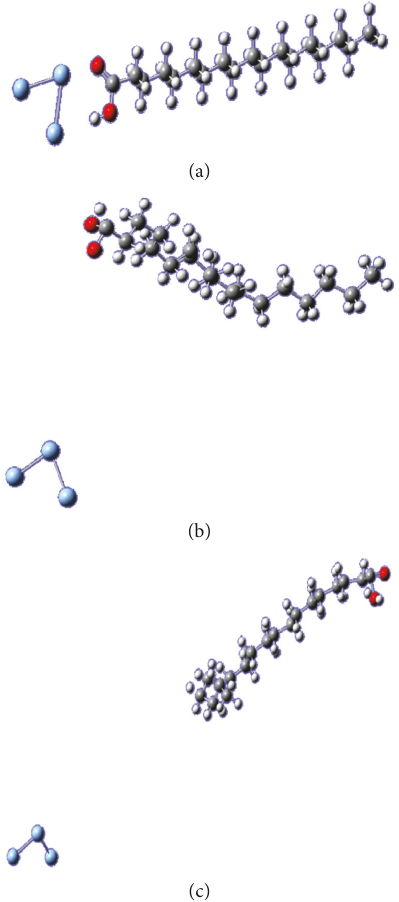
Figure 11: Molecular dynamics performed at 298.15K. Stearic acid with 3 silver atoms cluster at (a) 0ps, (b) 5ps, and (c)